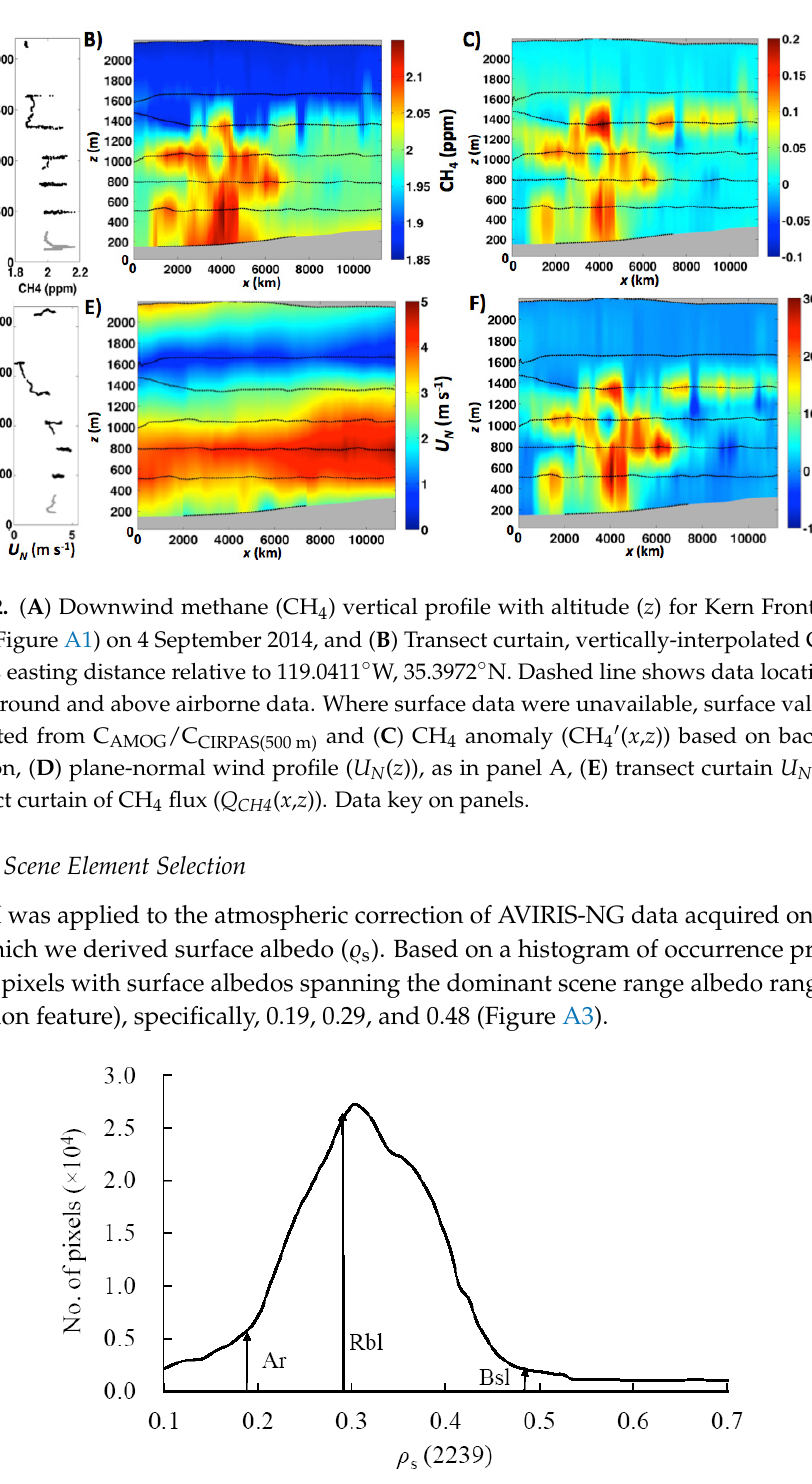
Figure A3. Scene occurrence histogram for surface albedo (ρ s ) for 2239 nm derived from FLAASH atmospheric correction of AVIRIS-NG data on 4 September 2014. ρ s (2239) for the three pixels Asphalt road (Ar), Brown sandy loam (Bsl), and Reddish brown sandy loam (Rbl), identified on figure. Element pixel occurrence was calculated from a spectral similarity parameter between AVIRIS-NG retrieved ρ s and albedo spectra in ENVI spectral library. The parameter combines Euclidean distance with correlation coefficient [40]. The albedo spectra with the smallest similarity parameter